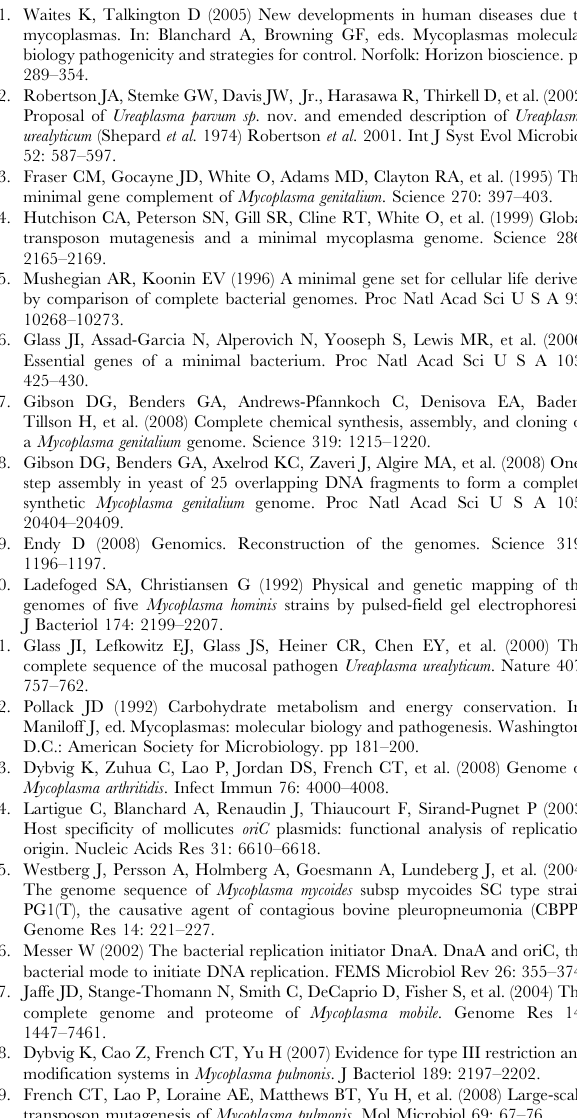
Table S2 The 247 genes shared by M. hominis , M. genitalium and U. parvum :transposon insertions in orthologs from M. pulmonis , M. arthritidis , and M. genitalium and orthologs in other human and animal mycoplasma sequenced genomes. The columns are as follows: (A) Gene name, (B) Product, (C) Locus in M. hominis PG21 (mnemonic), (D) Locus in M. genitalium G37 [3] (mnemonic), (E) Locus in U. parvum serovar 3 [11] (mnemonic), (F) Transposon insertion in ortholog from M. pulmonis according to [19], (G) Transposon insertion in ortholog from M. arthritidis according to [13], (H) Transposon insertion in ortholog from M. genitalium according to [6], (I–U) Predicted orthologs in other human and animal mycoplasma sequenced genomes, M. capricolum